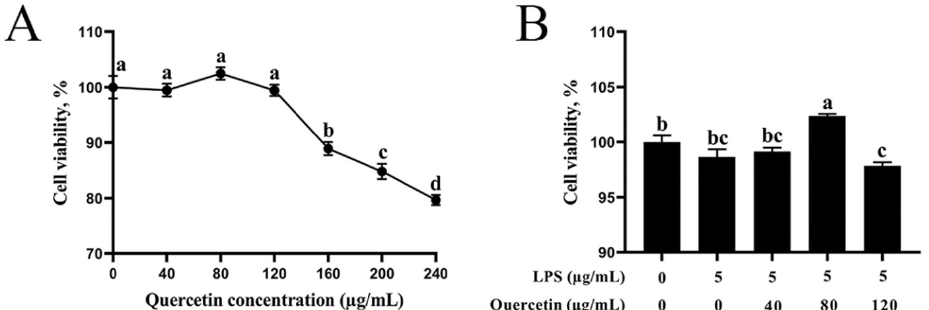
Figure 1. Impacts of quercetin on viable cells in LPS-induced BIECs. ( A ) Outcomes of quercetin on viable cells in BIECs. BIECs were treated with 40, 80, 120, 160, 200, or 240 µ g/mL quercetin for 12 h. ( B ) Impacts of quercetin on cell vitality in LPS-induced BIECs. BIECs were given 5 µ g/mL LPS and various densities of quercetin (40, 80, or 120 µ g/mL) for 6 h. Records from the control group were employed to normalise the findings of each experimental group. The results are mean ± SEM (n = 6). Various lowercase letters in the line graph reveal significant differences ( p < 0.05).